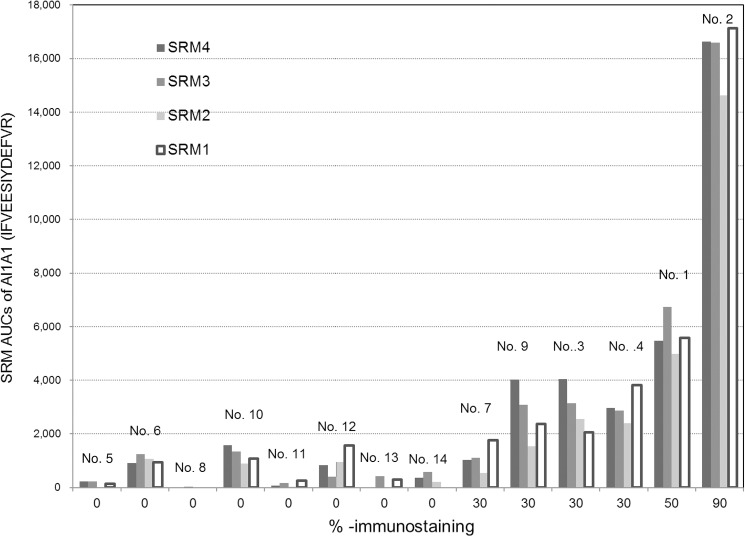
For each patient, the SRM AUCs are represented in histograms, together with patient numbers and %-values of immunostaining for AL1A1 (14 cases in S1 Table: LCNEC Patient No. 1–4, LCC Patient No. 11–15, SCLC Patient No. 21–25), in which the four SRM transitions for AL1A1 peptide, IFVEESIYDEFVR, [SRM1: m/z 823.4 (2+) → m/z 1028.5 (1+); SRM2: m/z 823.4 (2+) → m/z 1157.5 (1+); SRM3: m/z 823.4(2+) → m/z 1286.6 (1+); SRM4: m/z 823.4 (2+) → m/z 1385.7 (1+)] were used.